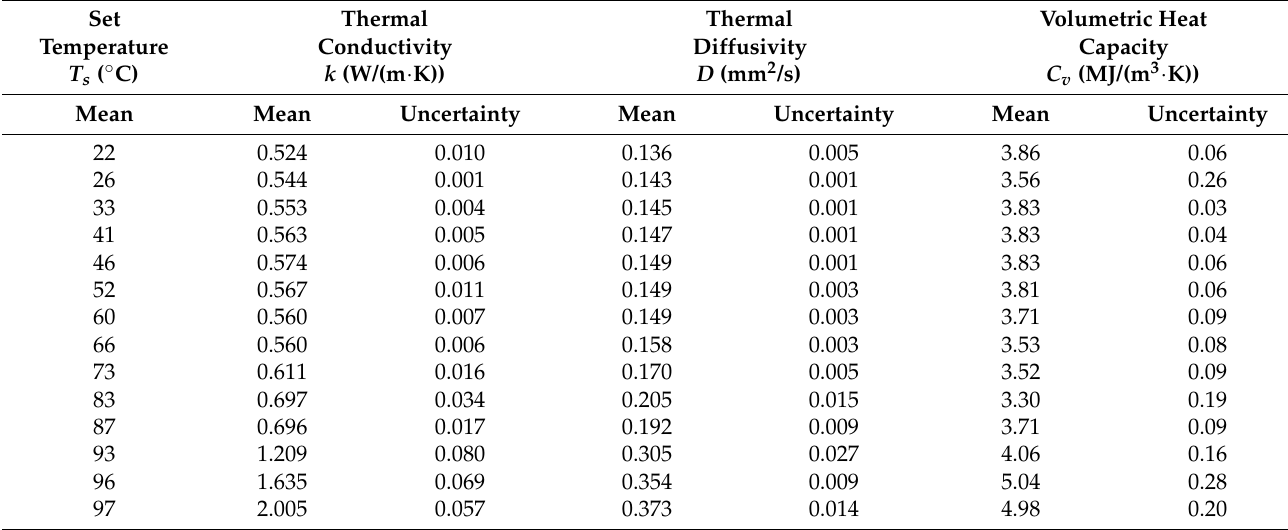
Table 3. Measured thermal properties for ex vivo calf brains at different temperatures and their associated measurement uncertainty with 95% confidence level.